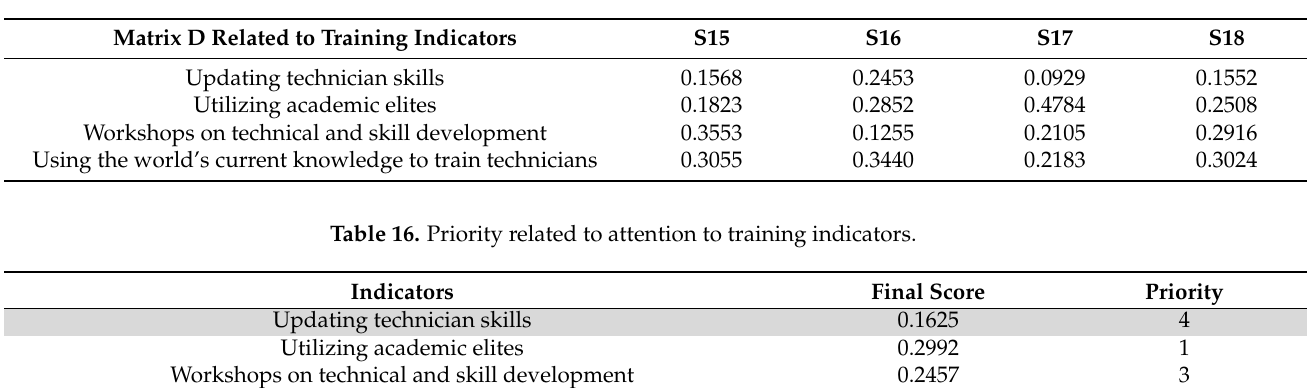
Table 15. The normalized matrix related attention to training indicators.